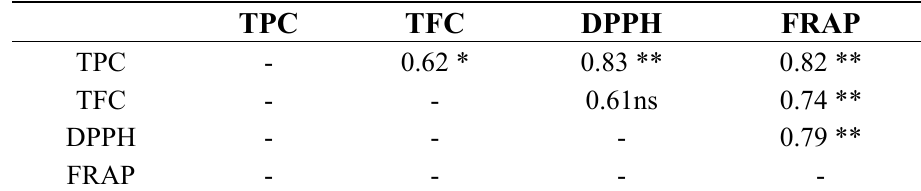
Table 3. Correlation coefficients between total phenolic compounds, total flavonoid content and antioxidant activity determination assays (DPPH and FRAP) of cassava. TPC TFC DPPH FRAP TPC - 0.62 * 0.83 ** 0.82 ** TFC - - 0.61ns 0.74 ** DPPH - - - 0.79 ** FRAP - - - - For correlation coefficients, n = 18; ns, *, ** Non significant or significant at p ≤ 0.05 and p ≤ 0.01,